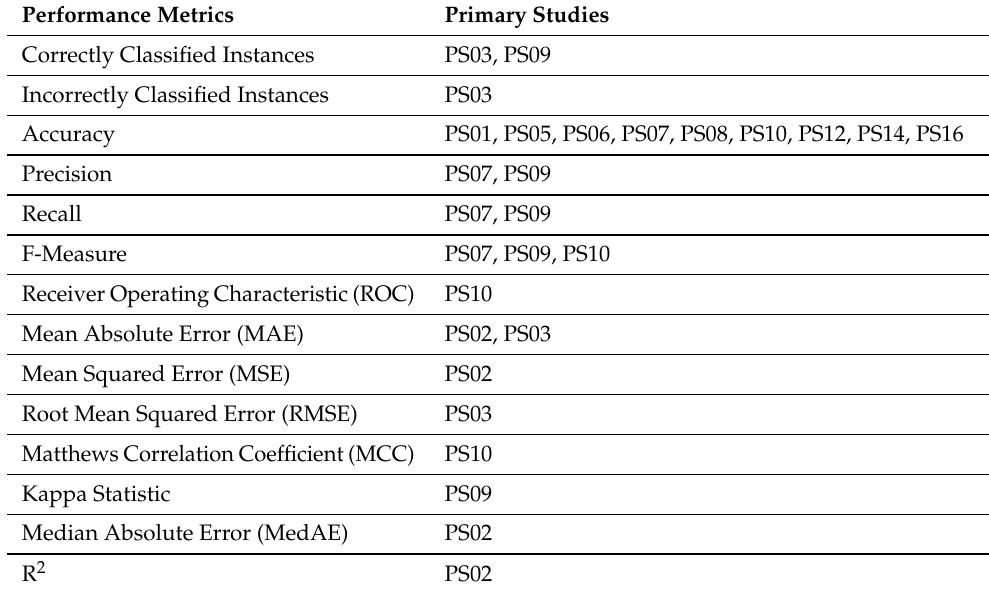
Table 8. Employed performance metrics.